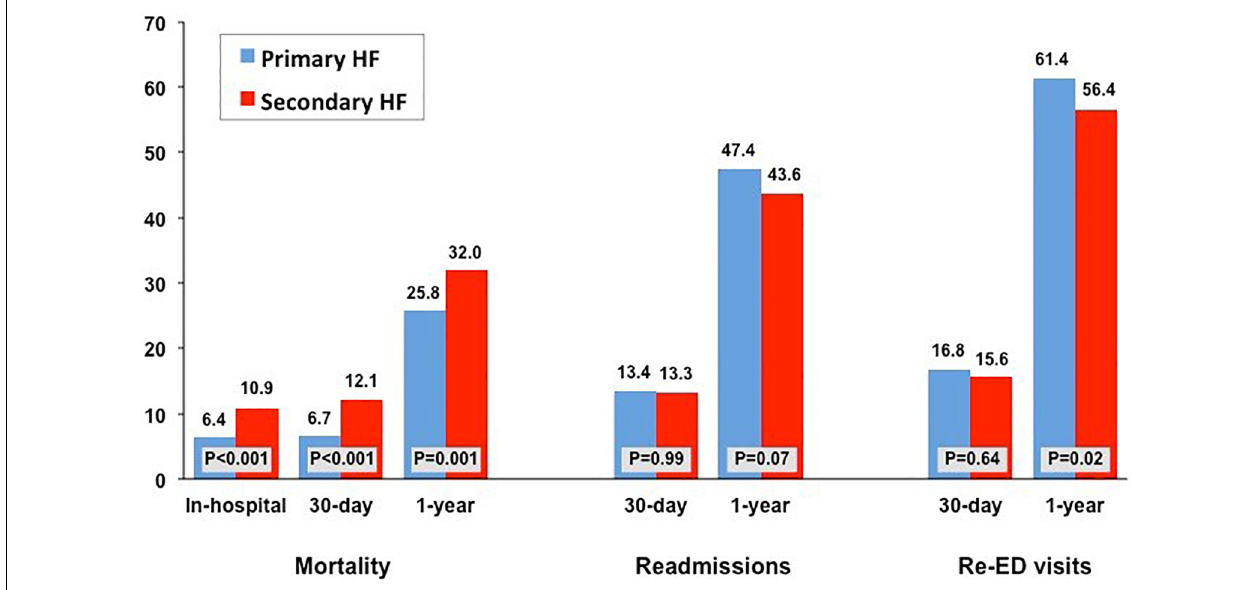
FIGURE 1 | Rates of in-hospital, 30-day and 1-year mortality rates, 30-day and 1-year readmission rates, and 30-day and 1-year new emergency department (ED) visits according to the type of heart failure diagnosis: primary and